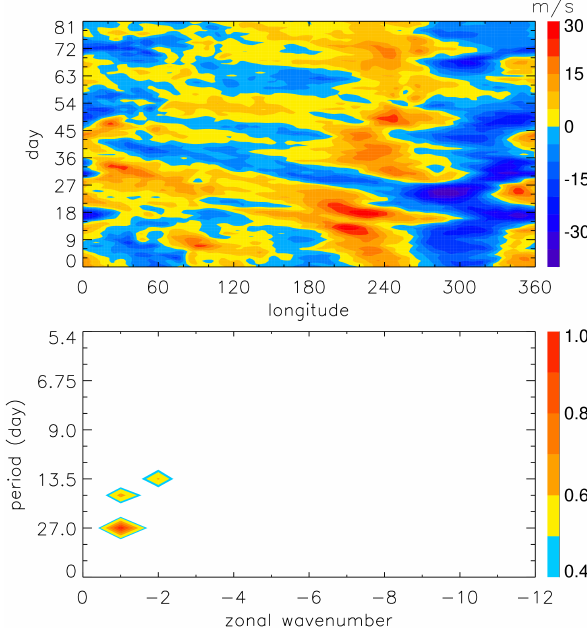
Figure 9. Top: zonal wind disturbance at 10hPa over 20 ◦ N derived from NCEP/NCAR reanalysis data. Bottom: normalized period– wavenumber spectrum of zonal wind